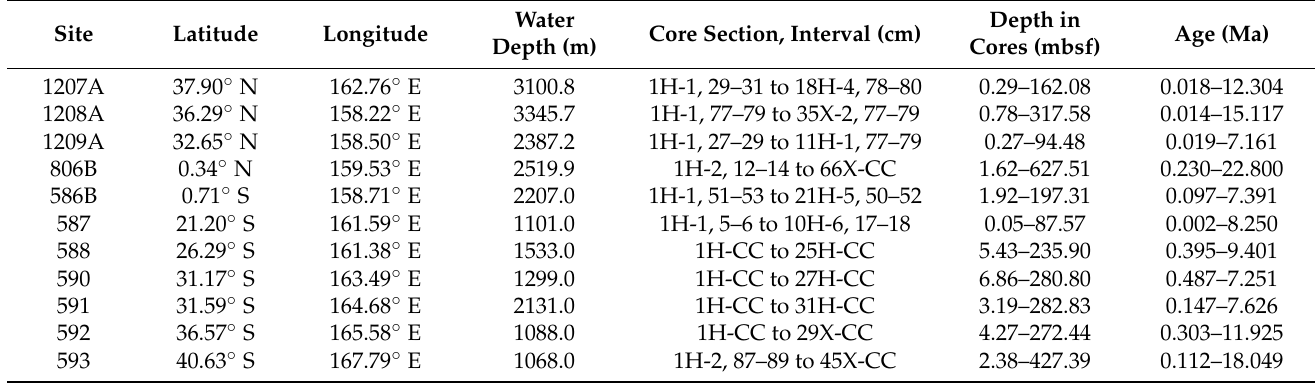
Table 1. Site latitude and longitude, water depths, core intervals utilized in this study, depths in the cores, and associated age of